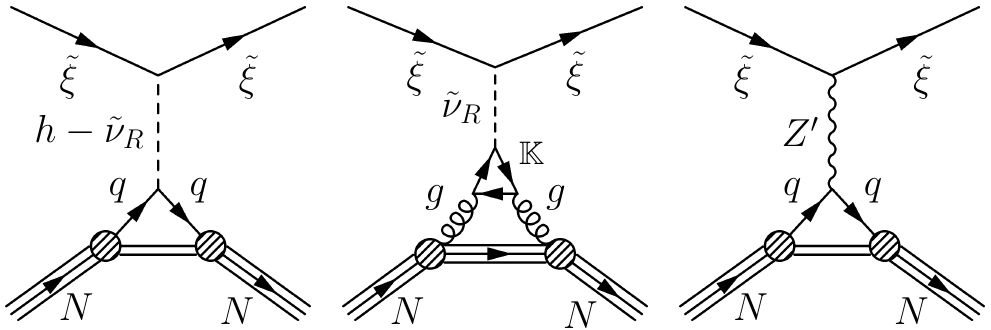
Figure 6. Diagrams contributing to DM scattering with nucleons mediated by (left panel) SM-like Higgs h and right sneutrinos ˜ ν R via mixing, (middle panel) right-handed sneutrinos ˜ ν R and induced by loop effects involving heavy exotic quarks K , (right panel) Z (cid:48) gauge